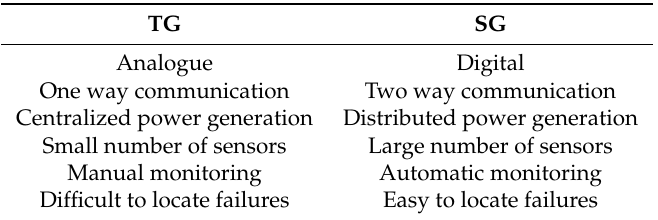
Table 1. Differences between TG and